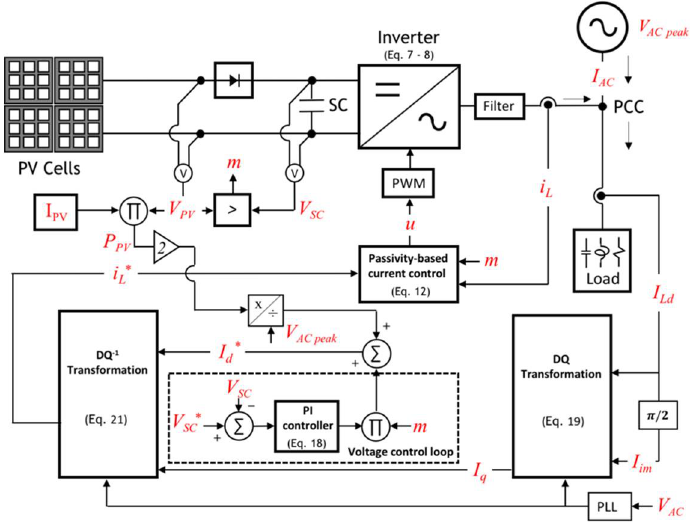
Figure 3. Block diagram of the proposed control scheme.